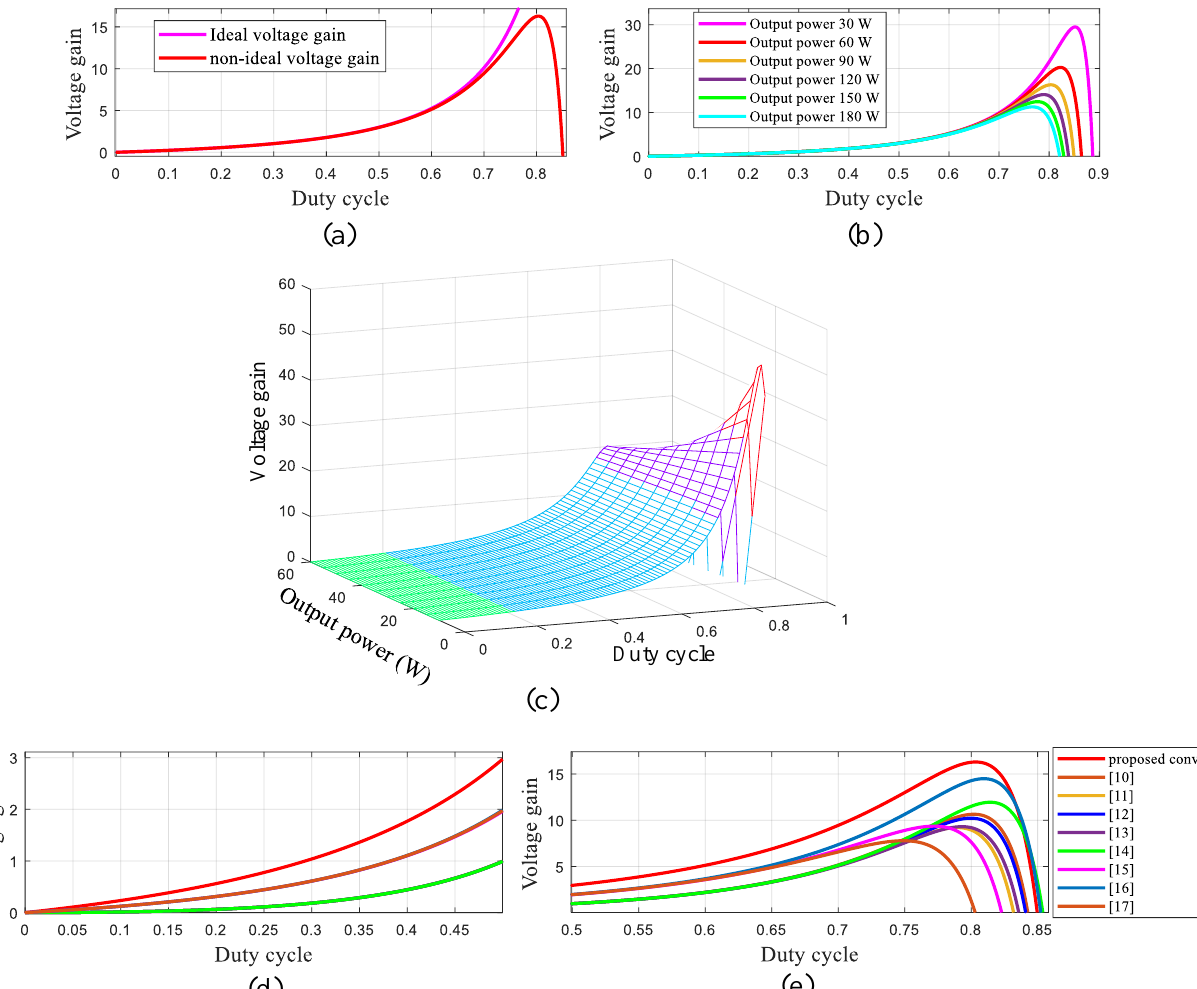
Figure 4. ( a ) Comparison of ideal and non-ideal voltage gain; ( b ) comparison of non-ideal voltage gain for different output powers; ( c ) behavior of the voltage gain with respect to the varying duty cycles and output power; ( d ) comparison of the voltage gain of the high gain converter for the varying duty cycles from 0 to 50 percent; ( e ) comparison of the voltage gain of high gain converter for the varying duty cycles from 50 to 85